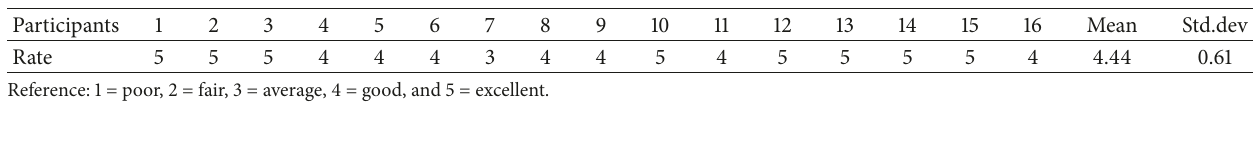
Table 3: Affective evaluation on